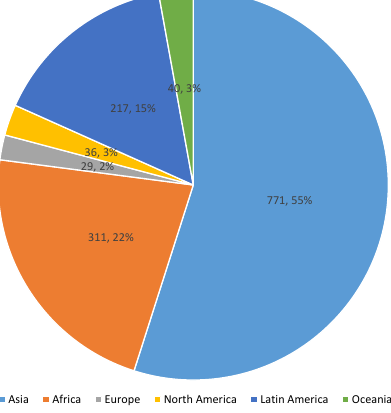
Figure 1. Last-Minute Regional Traveler